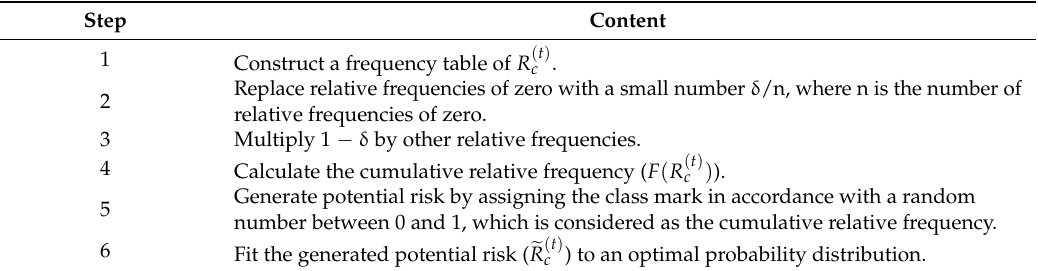
Table 2. Procedure for potential risk generation and probability distribution fitting (modified from [15]).